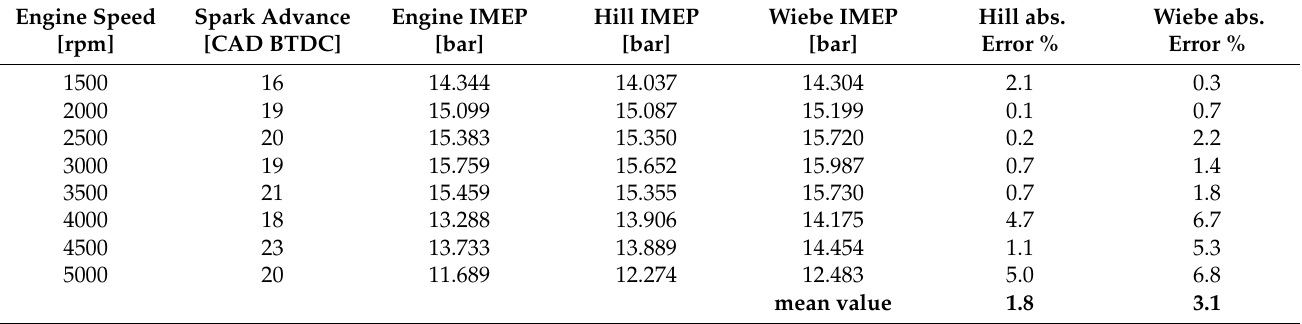
Table 11. Experimental and simulated IMEP with absolute prediction errors (60% NG; MAP = 1.6